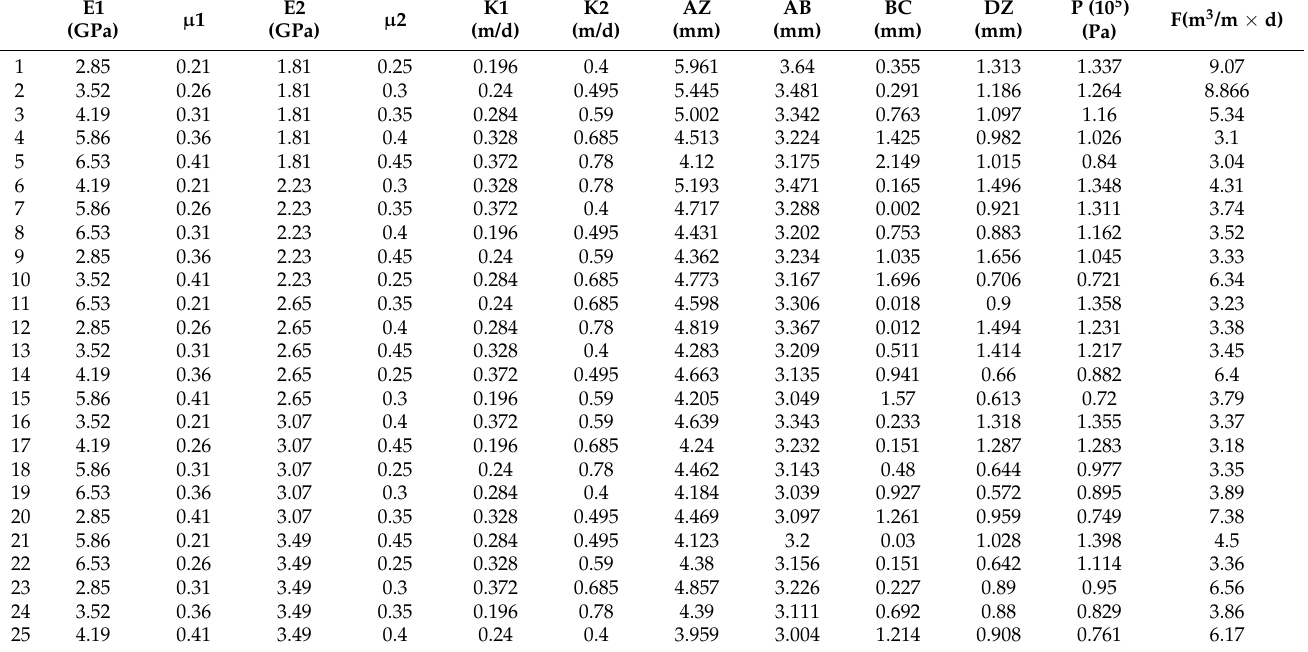
Table 2. Tunnel-surrounding rock parameters’ orthogonal scheme and the calculation results.